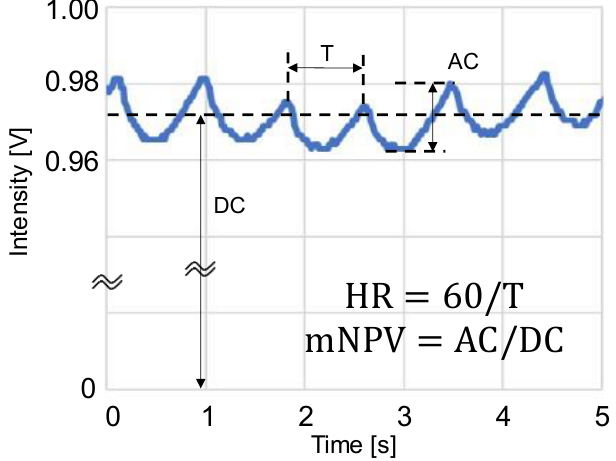
Figure 3. Schematic of photoplethysmogram (PPG) waveform feature values: AC is the amplitude of PPG, DC is the mean value of PPG, T is the peak interval time, HR = heart rate, and mNPV = modified normalized pulse volume [31].